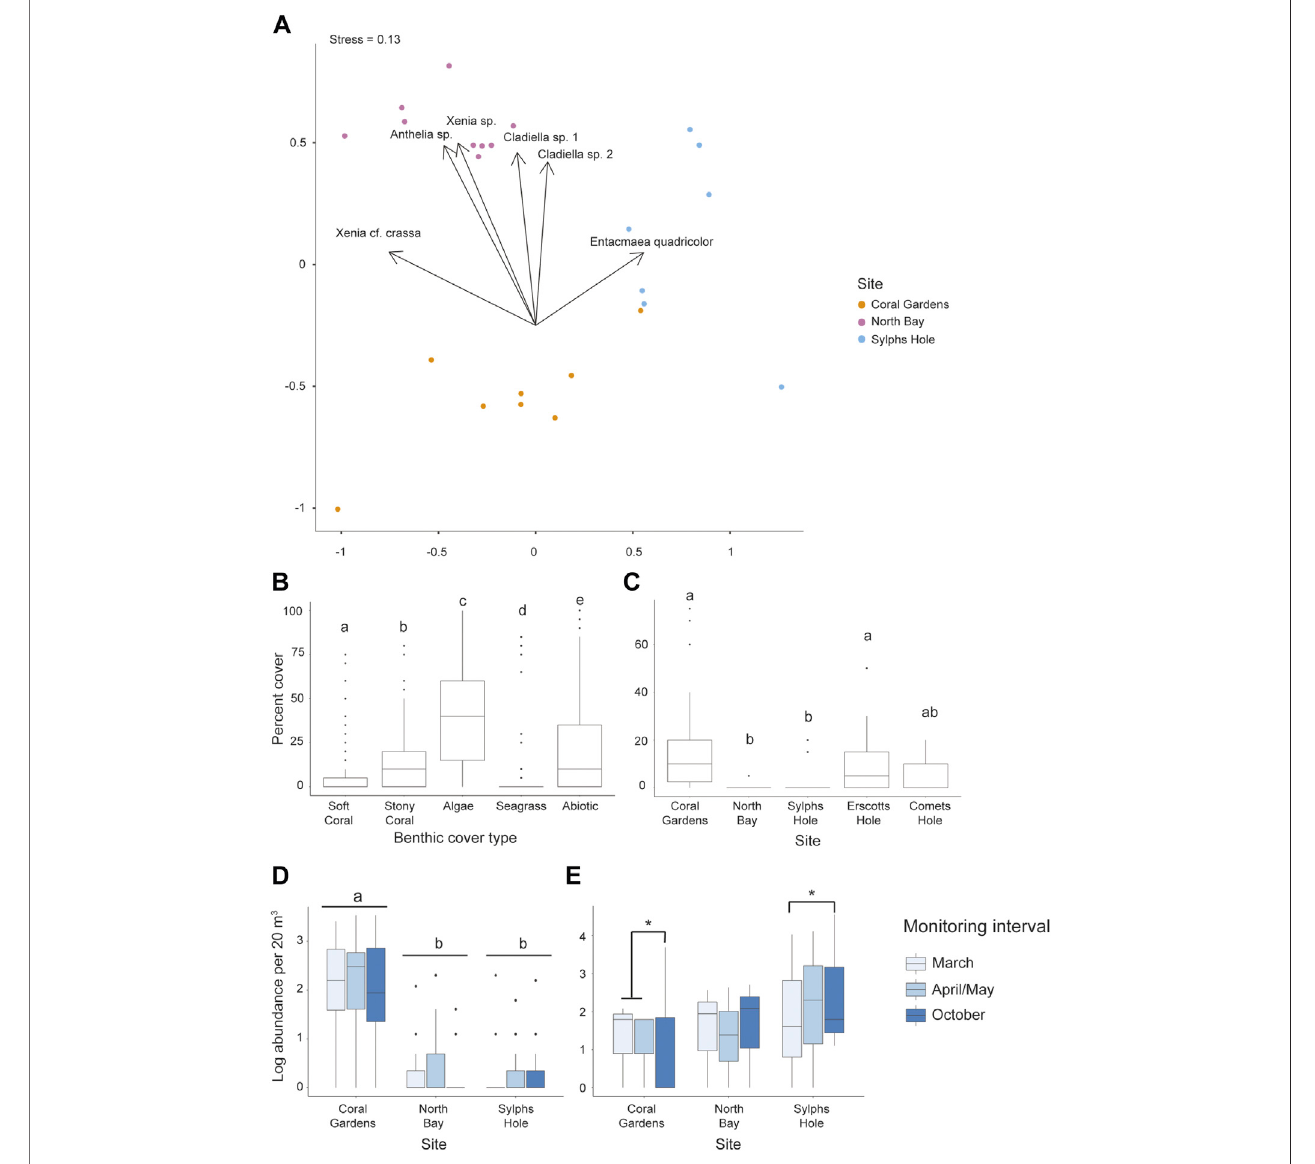
FIGURE 3 | Differences in the percent cover and abundance of octocorals and anemone among benthic groups, sites, and monitoring intervals in the Lord Howe Island lagoon. (A) NMDS ordination plot of species composition at each of the sites belt surveyed, Coral Gardens, North Bay, and Sylph ’ s Hole, (B) percent cover from photo quadrats of each benthic group (octocoral, stony coral, algae, seagrass, and abiotic factors) across the lagoon, (C) percent octocoral cover from photo quadrats across 5 sites in the lagoon, (D) abundance (log) from belt transects of six species of octocoral across three sites in the lagoon, and (E) abundance (log) from